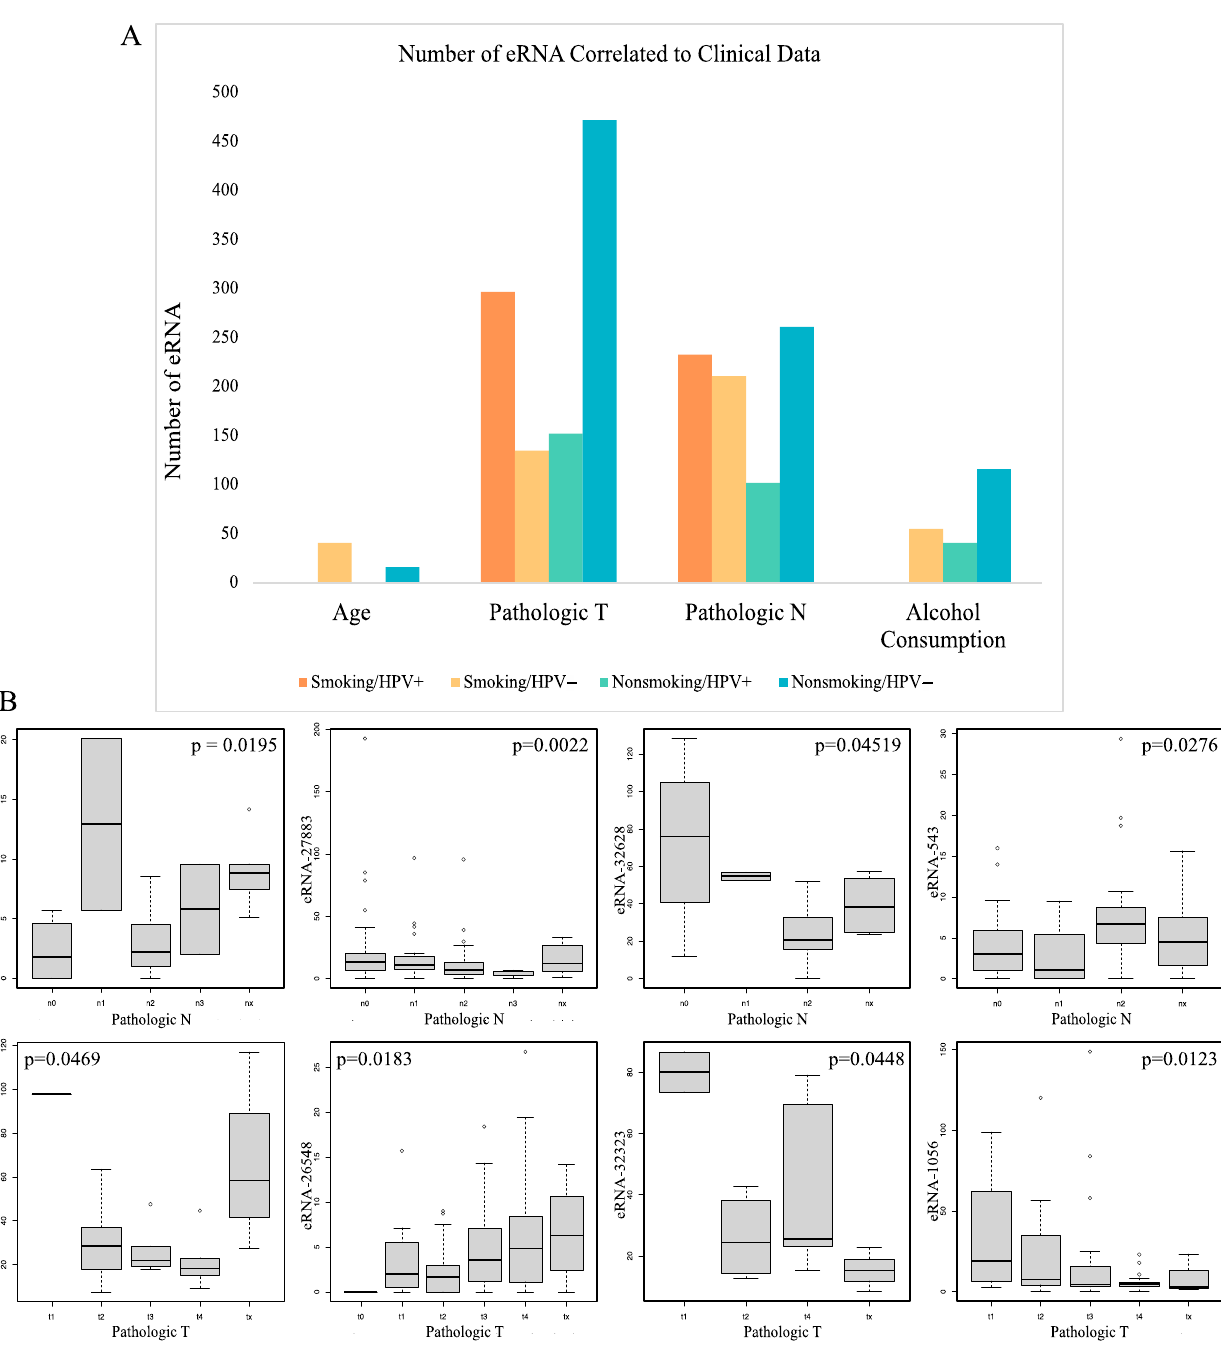
Figure 4. Correlation of differentially expressed eRNA to clinical variables. ( A ) Bar plot of the number of eRNA correlated to clinical data including age, pathologic stage T, pathologic stage N, and alcohol consumption in each of the four study cohorts. ( B ) Box plots showing correlation of eRNA to pathologic N and pathologic T clinical variables with outliers represented by °. Box plots were created using the Kruskal–Wallis test with p < 0.05 considered significant.